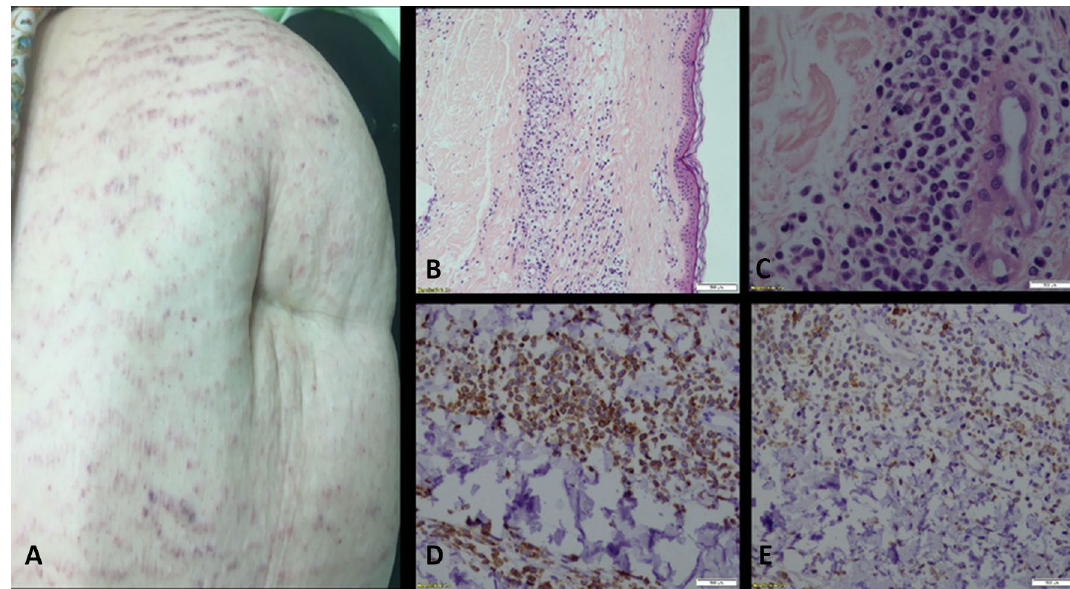
Figure 1. Leukemia cutis. A 42-year-old woman with AML who underwent biopsy of a skin eruption. ( A ) The patient presented with hyperleukocytosis and abdominal purple striae-like infiltrated plaques in a reticulated pattern. ( B , C ) A punch biopsy performed from the right abdomen revealed a mild perivascular infiltrate in the dermis, composed of medium-sized immature atypical cells, otherwise unremarkable. The epidermis shows no significant changes; note the subepidermal Grenz zone (H&E, X100). ( C ) Same as ( B ) at higher magnification (H&E X400). ( D , E ) The atypical cells stain positive for CD45 (X200) ( D ) ,CD4 (X200)) E ) ,HLA-DR, CD11c, CD68 and lysozyme. Cells are negative for CD3, CD20, CD79a, CD34, CD138, TdT, CD30, CD123 and cytokeratin. Ki67 shows a proliferative index of 25% in the infiltrates. The overall histological findings together with the immunohistochemical stains are compatible with AML involving the skin (leukemia